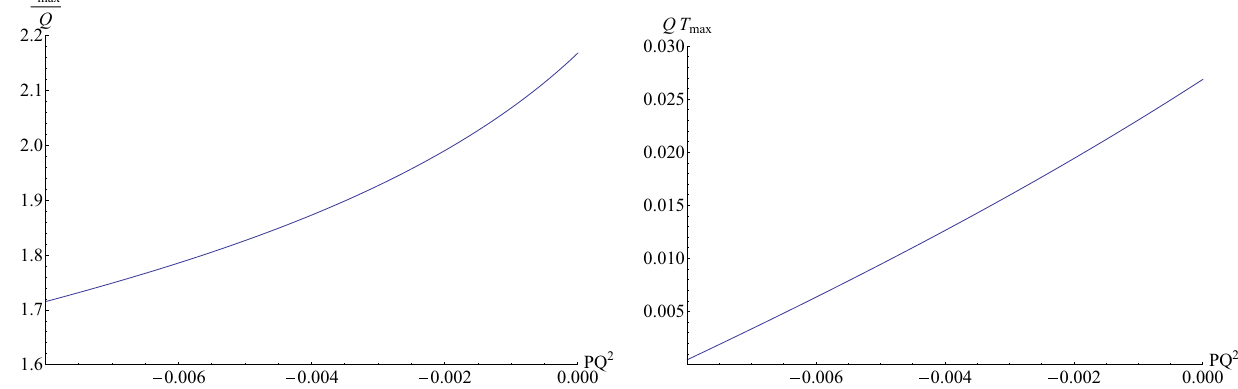
Fig. 5 We plot the reduced horizon radius r max / Q (left) and the reduced maximum temperature T max Q (right) in terms of the reduced pressure PQ 2